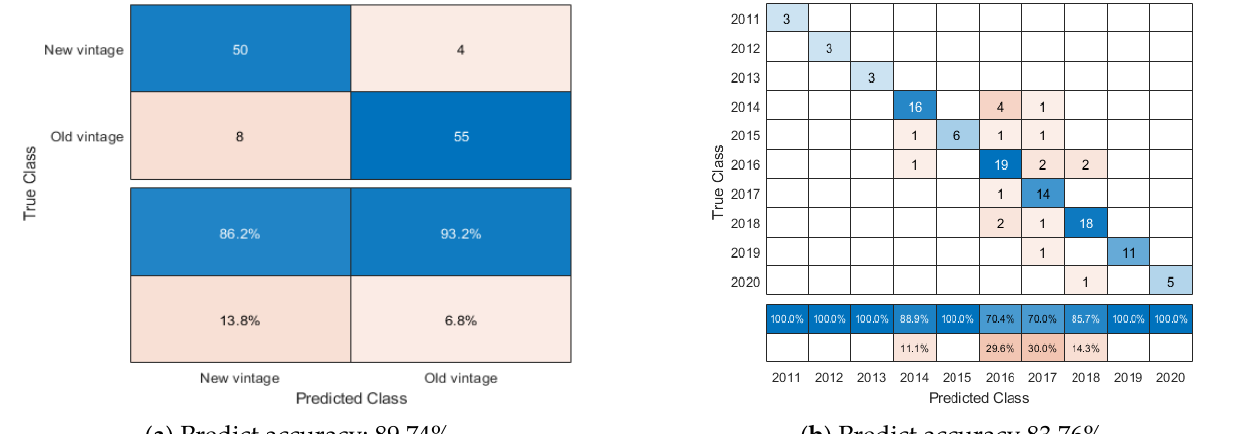
Figure 3. Confusion matrix about the soft sensor using a decision tree and Naive Bayes to predict New Zealand Pinot noir wines’ vintage ranges (old/new vintages) and vintages. ( a ) has displayed the confusion matrix of the soft sensor using decision tree when New Zealand Pinot noir wines’ vintages are classified into two categorize, namely old vintages (≤Vintage 2016), new vintages (>Vintage 2016). ( b ) has displayed the confusion matrix of soft sensors using Naive Bayes when New Zealand Pinot noir wines’ vintages.